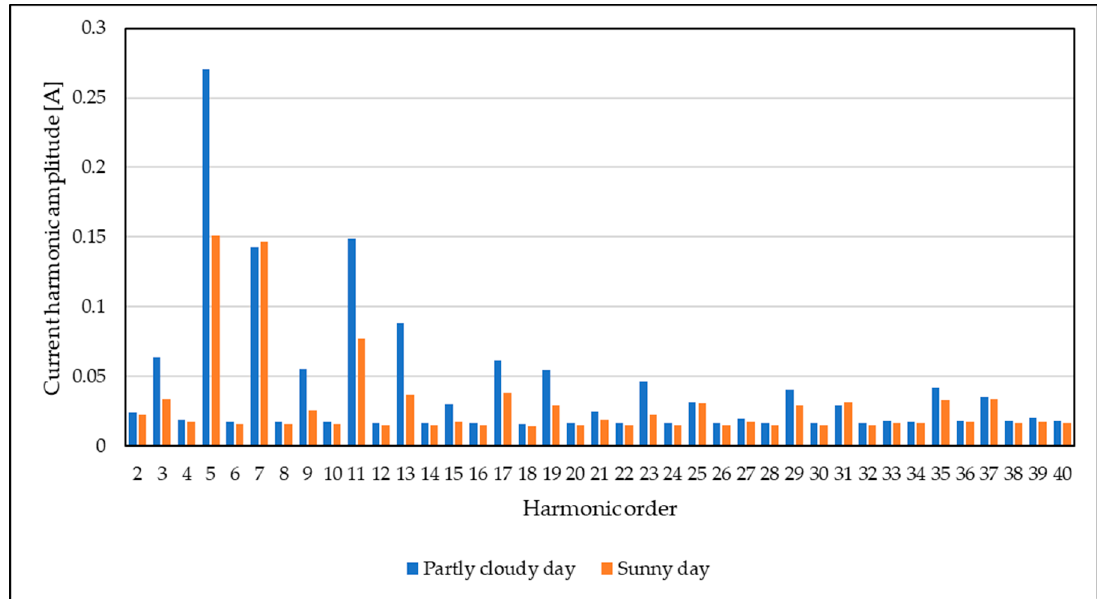
Figure 6. The current harmonic spectrum on a partially cloudy day (15 April 2018) and a sunny day (21 August 2018).